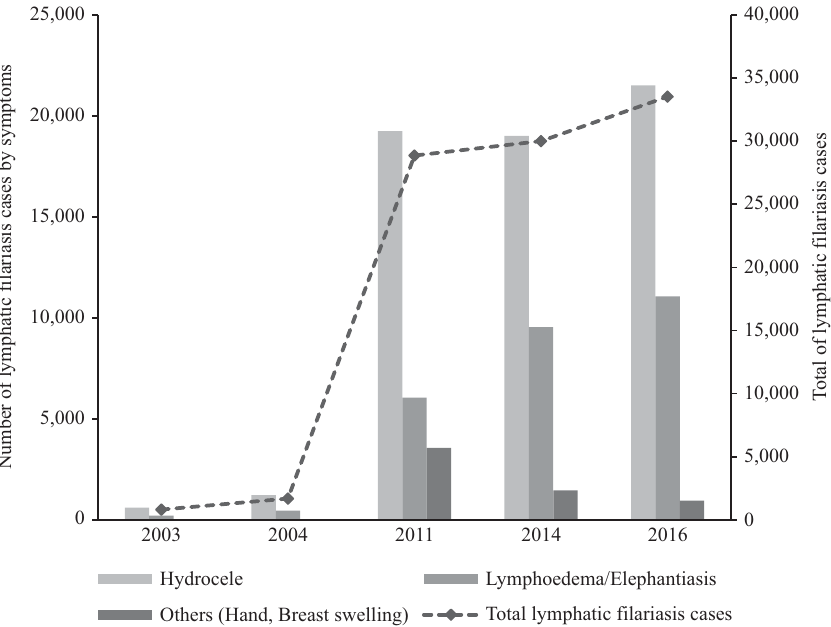
Figure 3. Lymphatic